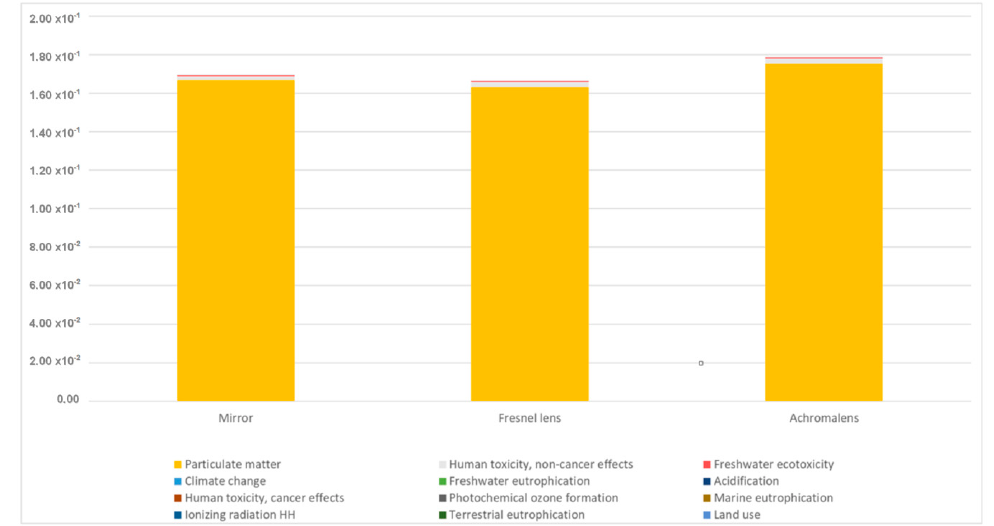
Figure 6. Weighted results excluding the mineral depletion category. Mirror, Fresnel lens, and Achromalens results are, respectively, 0.169, 0.166, and 0.179 pts. The particulate matter impact category domination represents 98%.